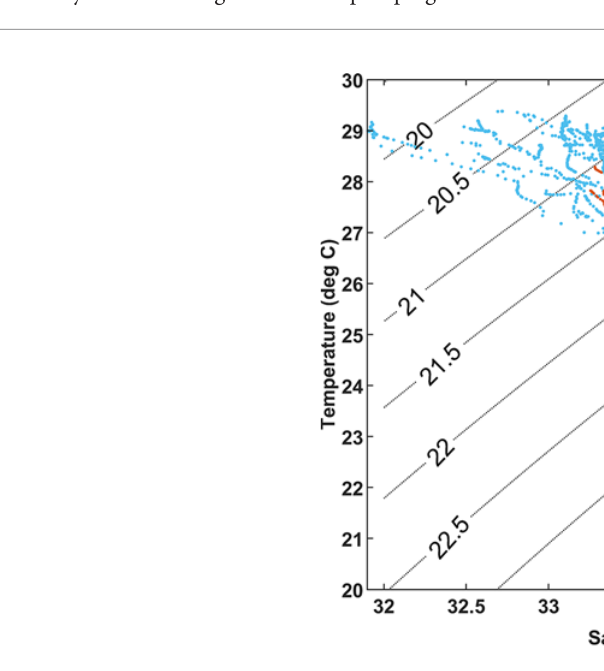
FIGURE 3 | T – S diagram of 62 stations from surface to 50 m depth. Blue solid points are water columns before the typhoon and orange solid points are water columns affected by the typhoon.